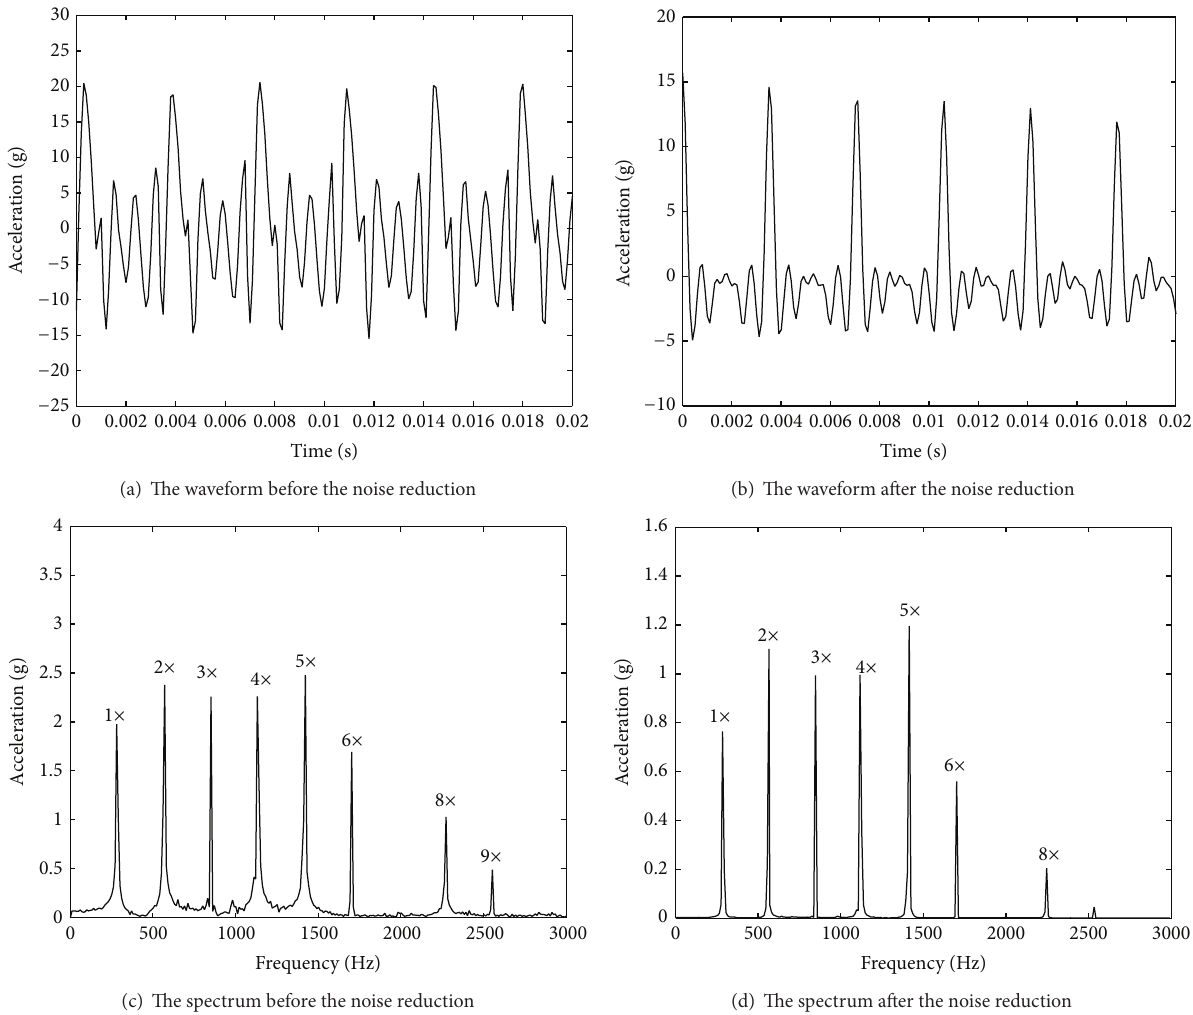
Figure 15: The time domain waveform and frequency spectrum before and after the noise reduction when rotating speed is 17000 rpm.